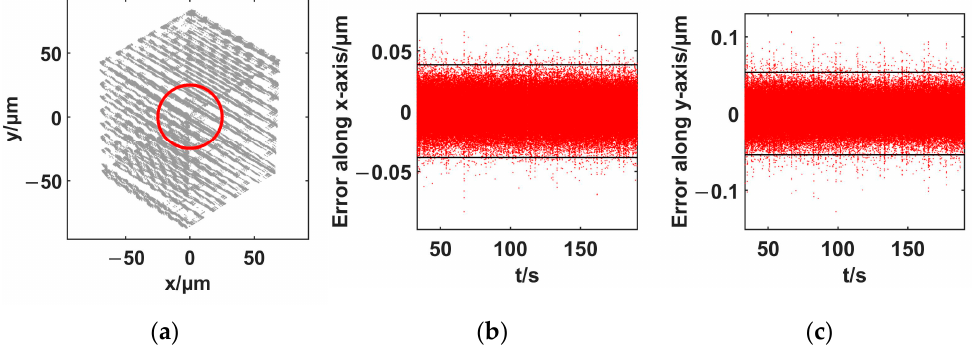
Figure 4. In-focus-plane motion generation ability using the proposed spatial nanopositioner. ( a ) planar workspace; ( b ) positioning error, x axis; ( c ) positioning error, y axis.